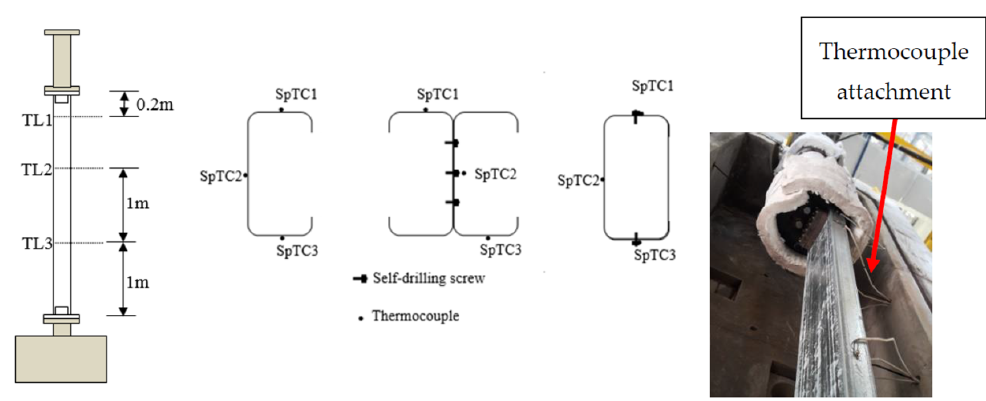
Figure 4. Thermocouple attachment along the column.